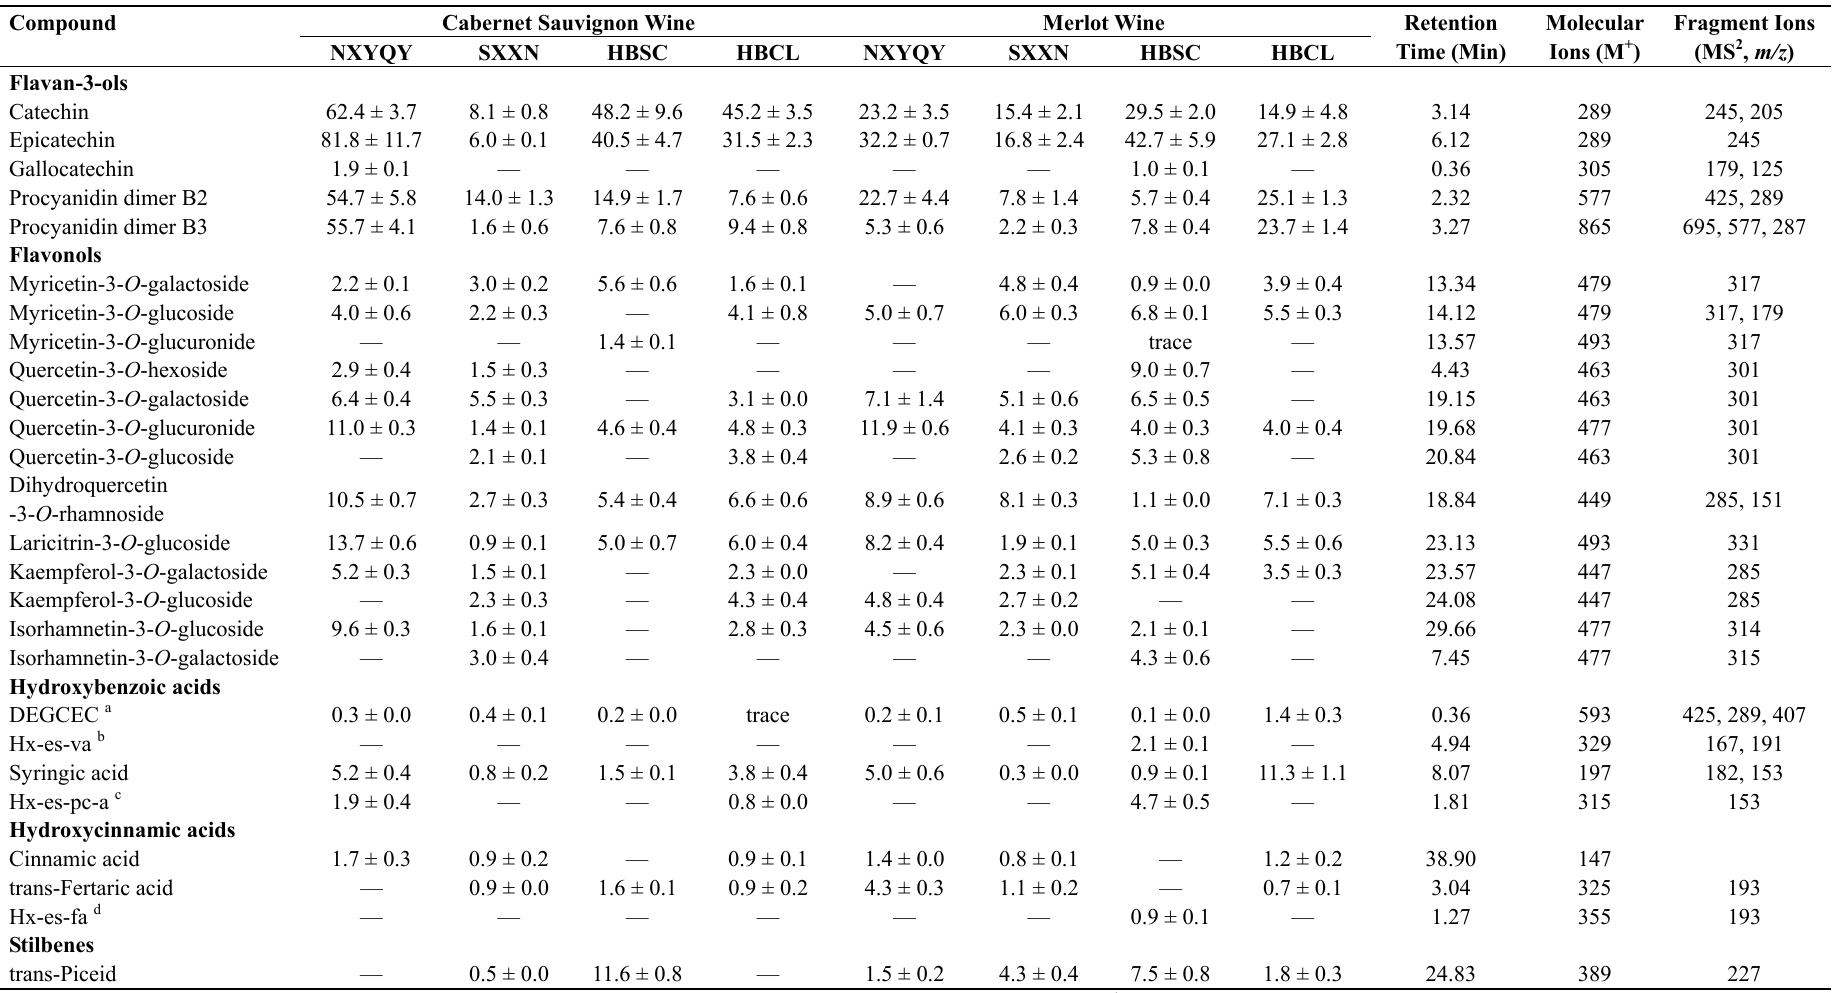
Table 2. Concentrations of individual phenolic compounds of Cabernet Sauvignon and Merlot wines from four different wine grape-growing regions (mg /L). Compound Cabernet Sauvignon Wine Merlot Wine Retention Molecular Flavan-3-ols Gallocatechin Flavonols Myricetin-3- O -galactoside Myricetin-3- O -glucoside Myricetin-3- O -glucuronide Quercetin-3- O -hexoside Quercetin-3- O -galactoside Quercetin-3- O -glucuronide Quercetin-3- O -glucoside